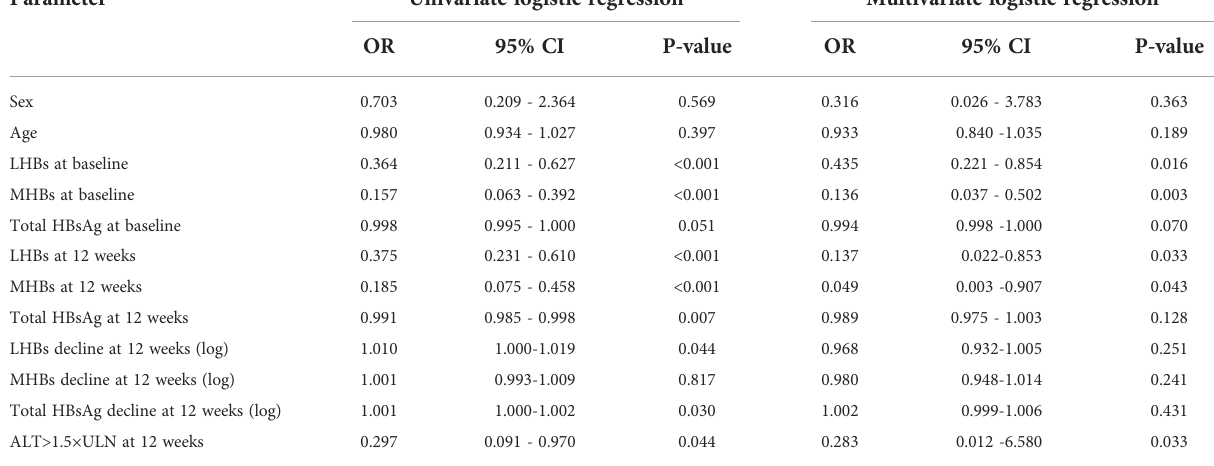
TABLE 2 Logistic regression.